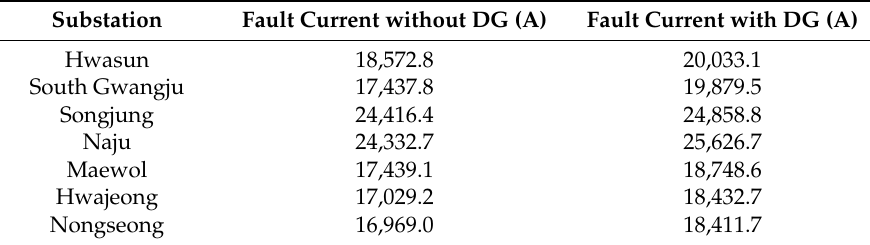
Table 5. Fault current